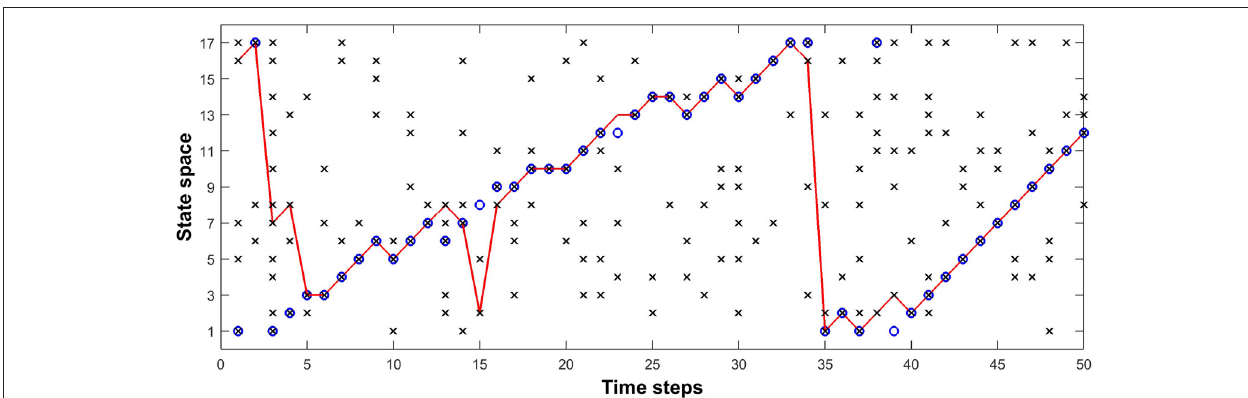
FIGURE 8 | Model tracking results. A fruit fly moves against a randomly flickering background ( β = 0.2). The sensory afferent neurons of the dragonfly fire probabilistically ( α = 0.9) if there is a fruit-fly in the foreground or a false target in the background of their receptive field, and the presence of a spike at each sensory neuron in either case is represented by “x.” Inference neurons compute the posterior probability for each possible state using a given transition probability—in the example we use (0.2, 0.1, 0.7) for ( Left, Stay, Right )—and a winner-take-all circuit determines the maximum a posteriori estimate of the fly’s position at each time, shown by the red curve. “ ” represents the fly position detected successfully by a sensory neuron, while “O” represents failure of the sensory neurons to detect the fly. This simulation shows that the dragonfly tracks the fruit fly even in the presence of distractors, with a prediction accuracy of 80% using the above-mentioned N